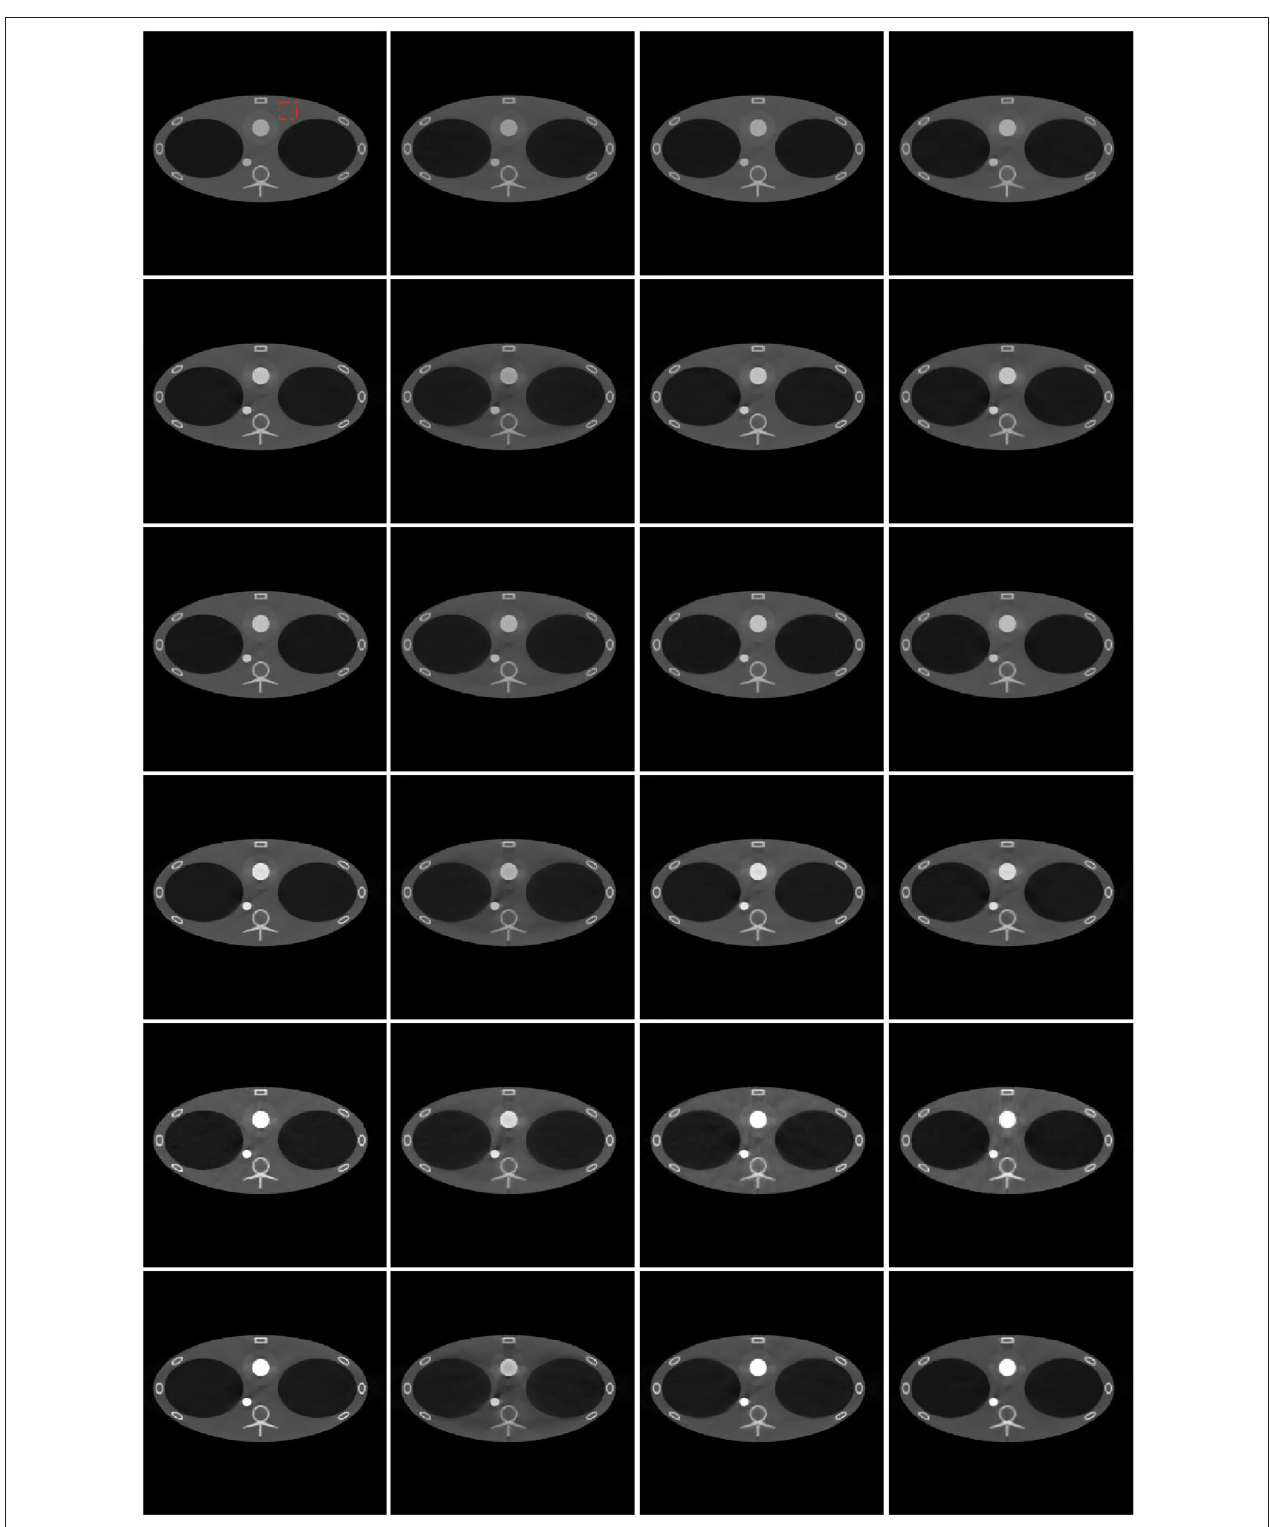
FIGURE 9 | Reconstruction results of different algorithms and energies. From top to bottom: 140 kV high energy, 140 kV low energy, 110 kV high energy, 110 kV low Energy, 80 kV high energy, 80 kV low energy. From left to right: scatter-free full-view (scatter-free-FV) results, scattered (scattered-FV) results, scatter corrected (scattered-corrected-FV) results, triple plane CT (TPCT) results. The red square in the left top image is the ROI. The display window is [ − 1000, 2000] HU.